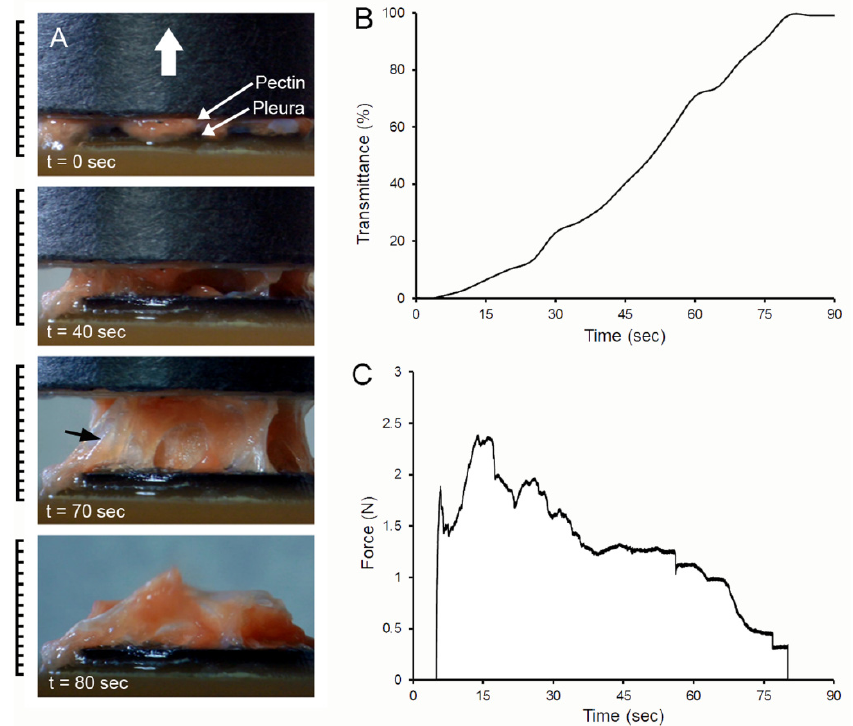
Figure 3. Probe withdrawal in the pectin–pleura adhesion test with simultaneous force–distance and videomicroscopy recordings. ( A ) The pectin film and a corresponding 1 mm thick patch of porcine visceral pleura were compressed at 5N for 60 s prior to probe withdrawal; the direction of the cylindrical probe movement (0.5 mm/s) is indicated by the white arrow. Separation of the surfaces is associated with submesothelial tissue rupture (black arrow). At the conclusion of the withdrawal, residual tissue can be observed adhering to the pectin film. ( B ) Progressive transillumination of the interface is shown by a percentage of optical transmittance. ( C ) The force required to maintain the probe velocity (0.5 mm/s) is shown.